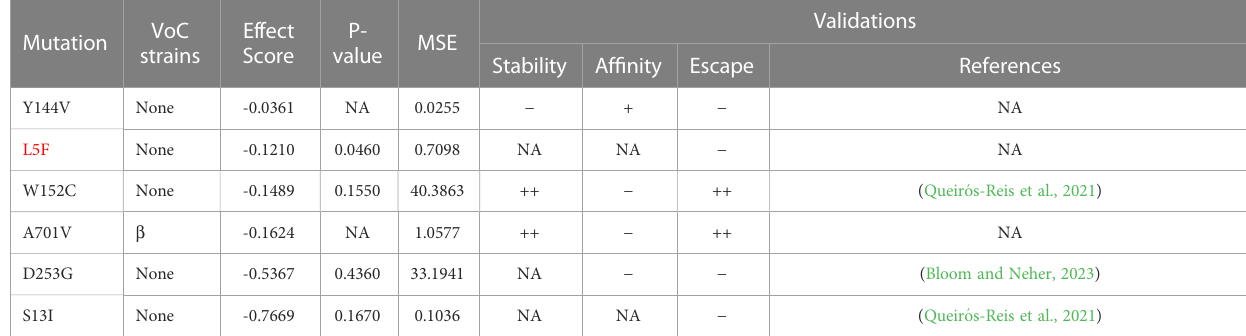
RBD proteins, particularly RBD-1, exhibit stronger af fi nity to ACE2